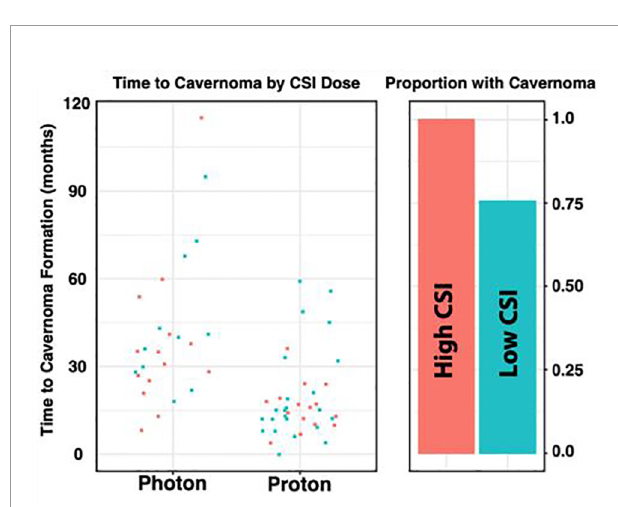
FIGURE 2 | Distribution of Radiation Dose by Radiation Type. The photon and proton groups are divided into STANDARD (n=33) and HIGH (n = 28) dose CSI radiation, based on a threshold of 33. Among both the Photon and Proton groups, it does not appear that CSI dosage has an effect on the Time to Cavernoma formation (p = 0.49 and 0.29 respectively). Similarly, we do not observe a signi fi cant relationship between CSI dosage and formation of a cavernoma in the Photon or Proton groups (p = 0.99 and 0.77 respectively). However, when the groups of photon and proton were combined, a signi fi cant relationship between the CSI dosage and formation of CMs was noted (p